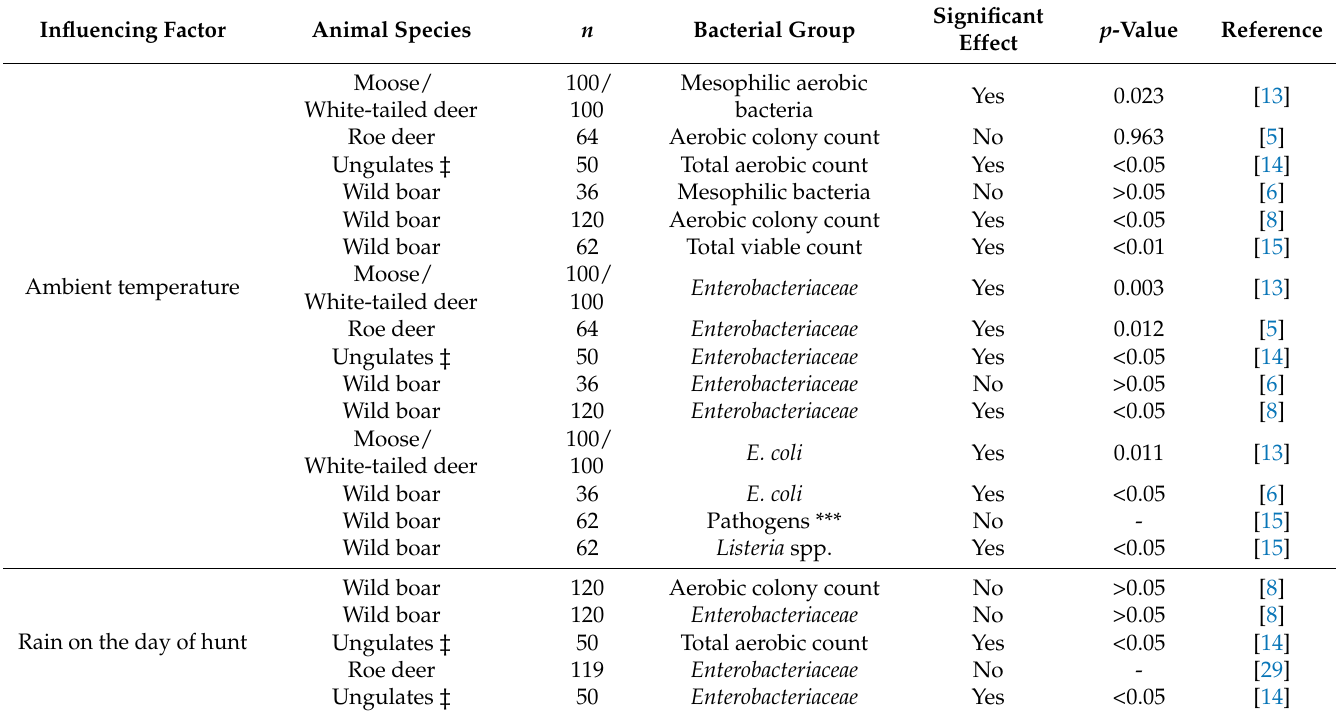
Table 3. Environmental factors that may influence the initial microbial load of game carcasses including animal species, sample size, p -value and bacterial group examined, reported in the original research articles.